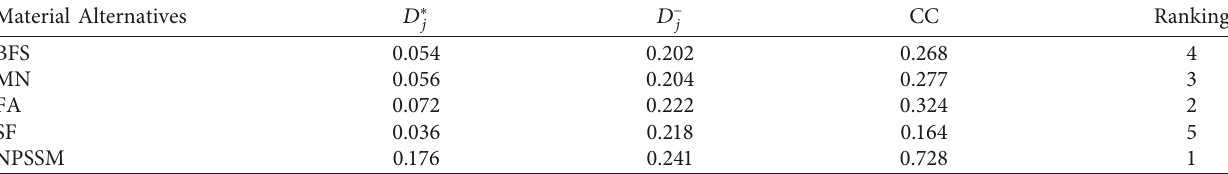
Table 9: Final ranking score obtained by TOPSIS.